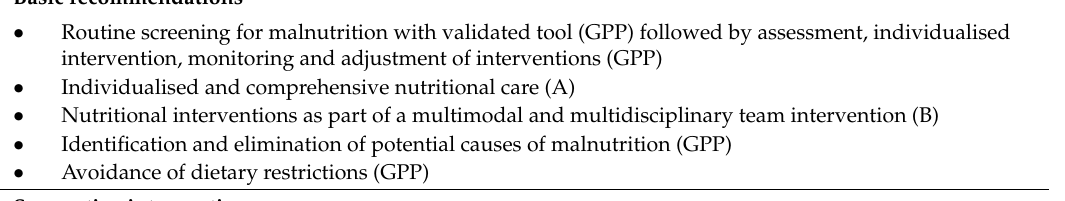
Table 1. Intervention strategies for the management of malnutrition (based on